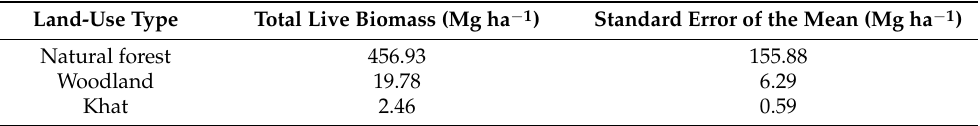
Table 5. Mean plant biomass and its standard error among the different land-use types.